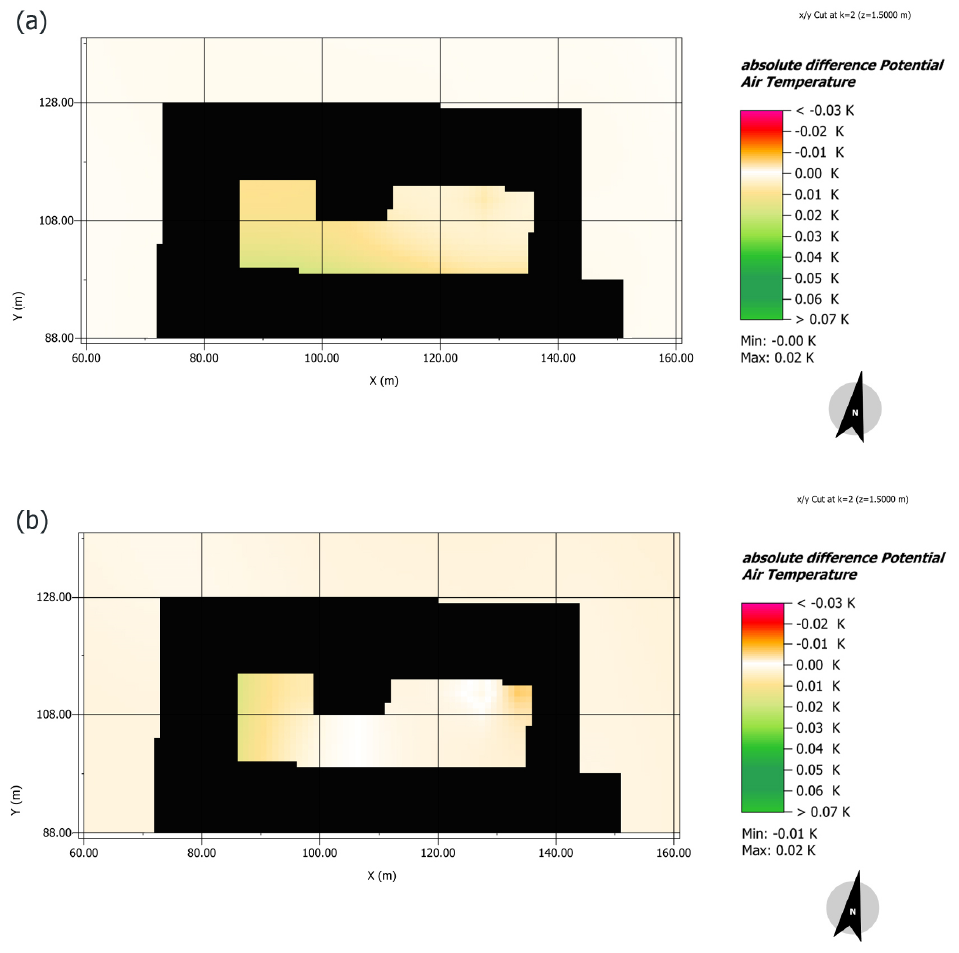
Figure 9. The green wall air temperature scenario with greenery placed on the southern ( a ) and western ( b ) wall. Figure by authors.